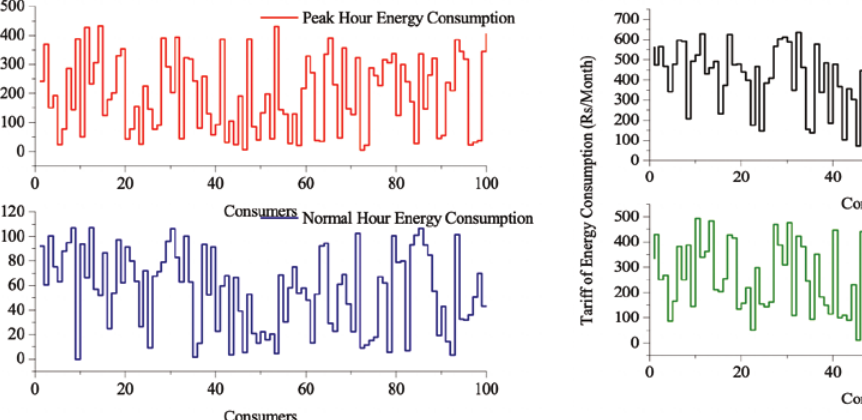
Figure 1: Agricultural consumers Energy Consumption during normal hours and peak hours